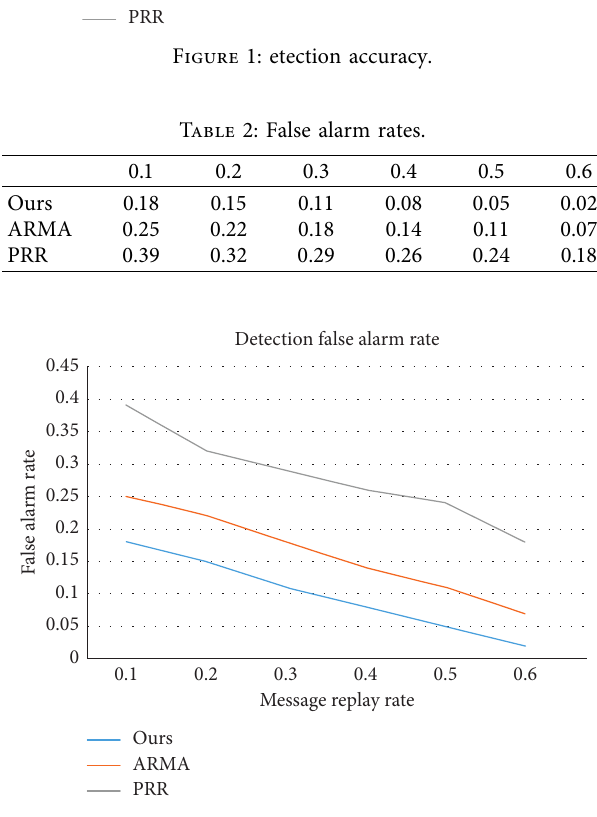
Figure 2: False alarm rates.